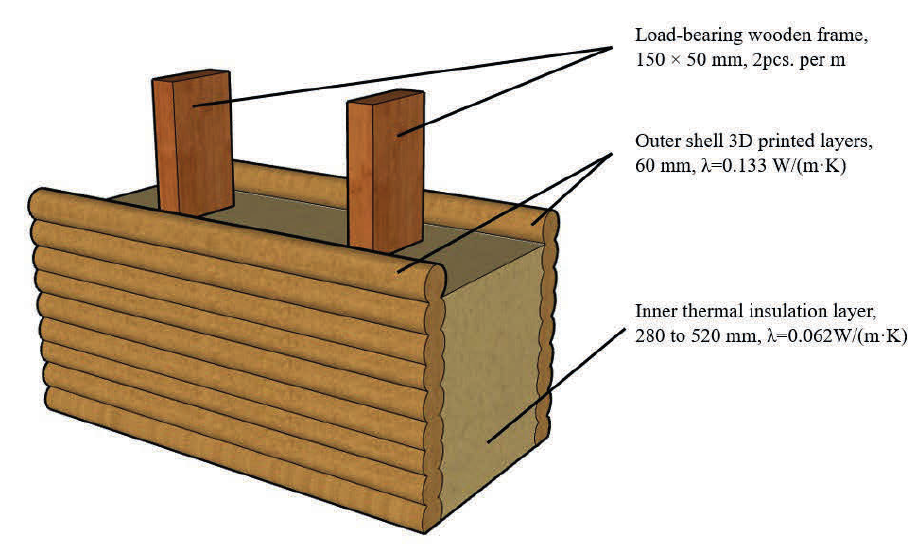
Fig. 1. Schematic 3D printed hempcrete wall